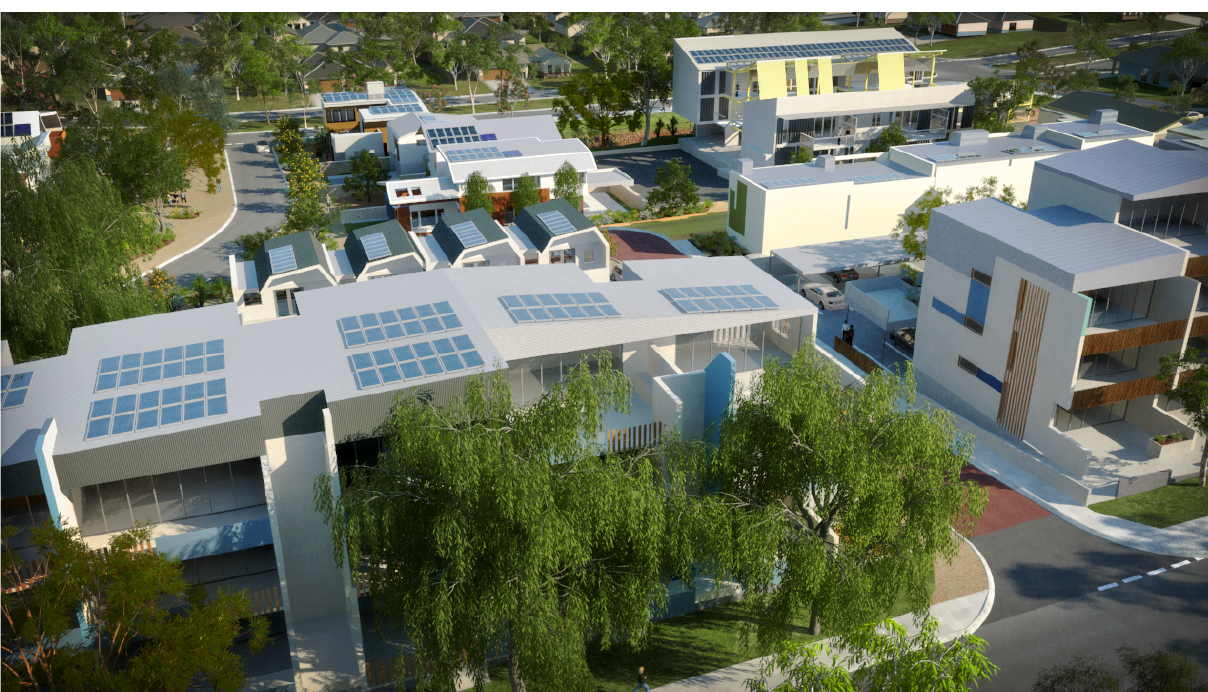
Figure 2. Artist impression of the WGV residential development, in the suburb of White Gum Valley. Source: LandCorp